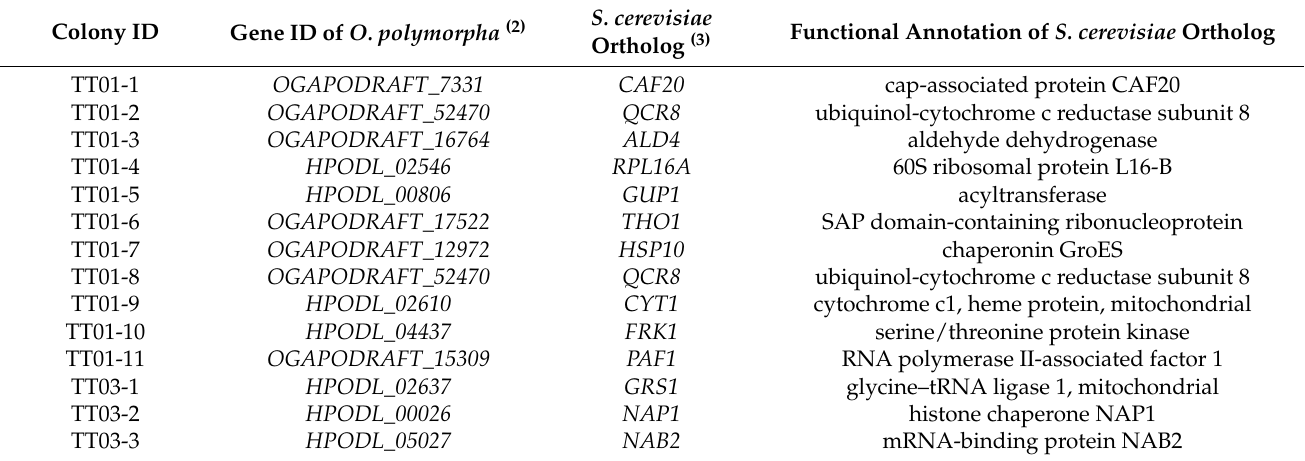
Table 2. Annotation of O. polymorpha genes obtained from colonies of heat-tolerant S. cerevisiae expressing O. polymorpha cDNA (1) . Colony